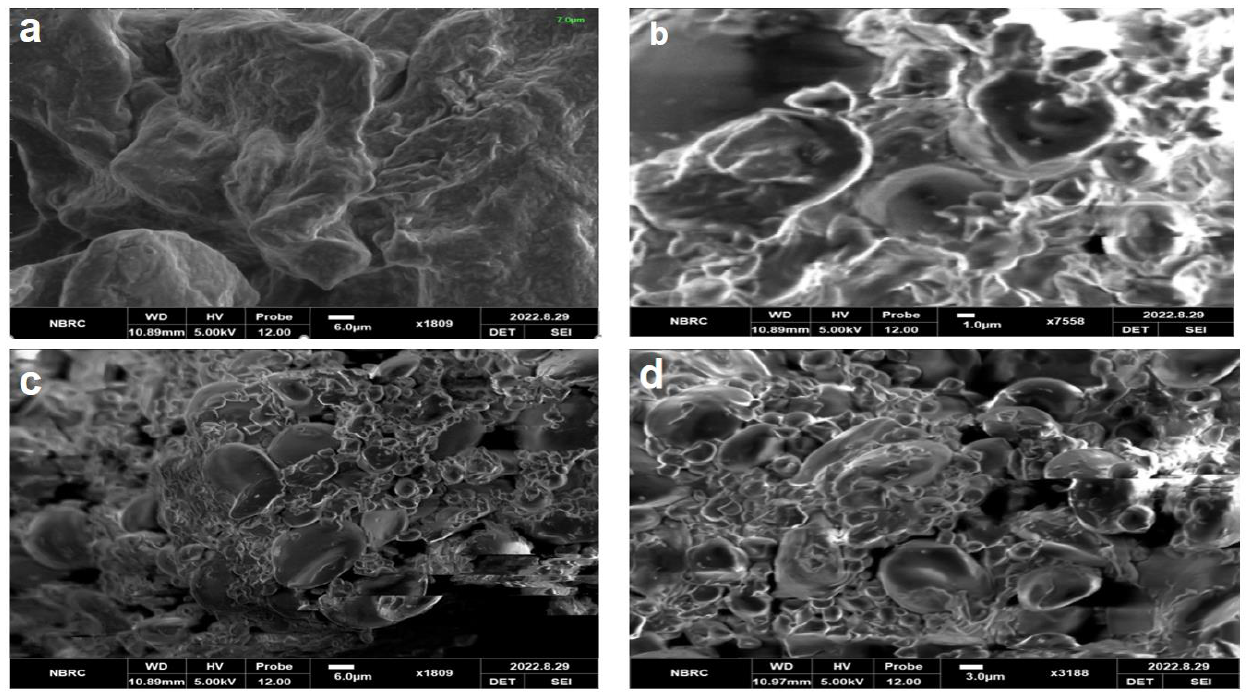
Figure 1. Scanning Electron Microscopy (SEM) ( a , b ) micrographs representing raw oat bran; ( c , d ) micrographs representing fermented oat bran. crographs representing fermented oat